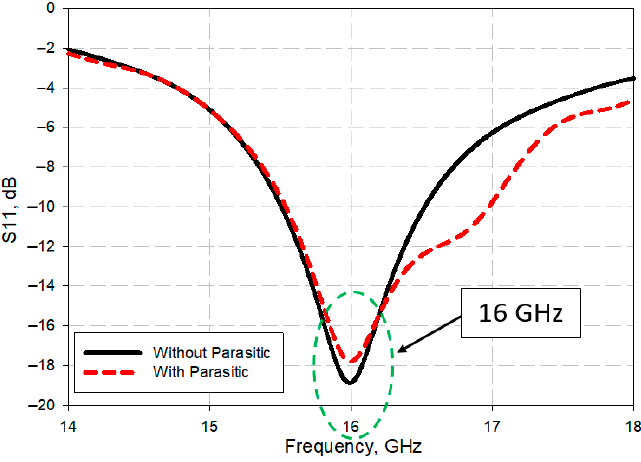
Figure 2. S11 performance of both antennas.